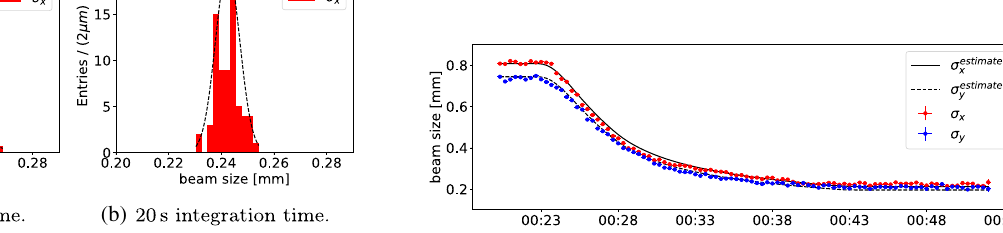
FIG. 16. BGV measurement of transverse beam size during the LHC acceleration phase. The expected beam size evolution given by Eq. (9) is also drawn. For clarity, the symbols used per data point are larger than the error bars of the